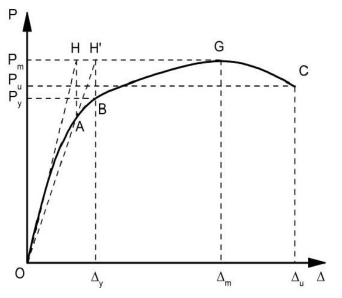
Table 3. S series and JD joint simulation results. Figure 6. Geometrical plotting method. Figure 6. Geometrical plotting method.